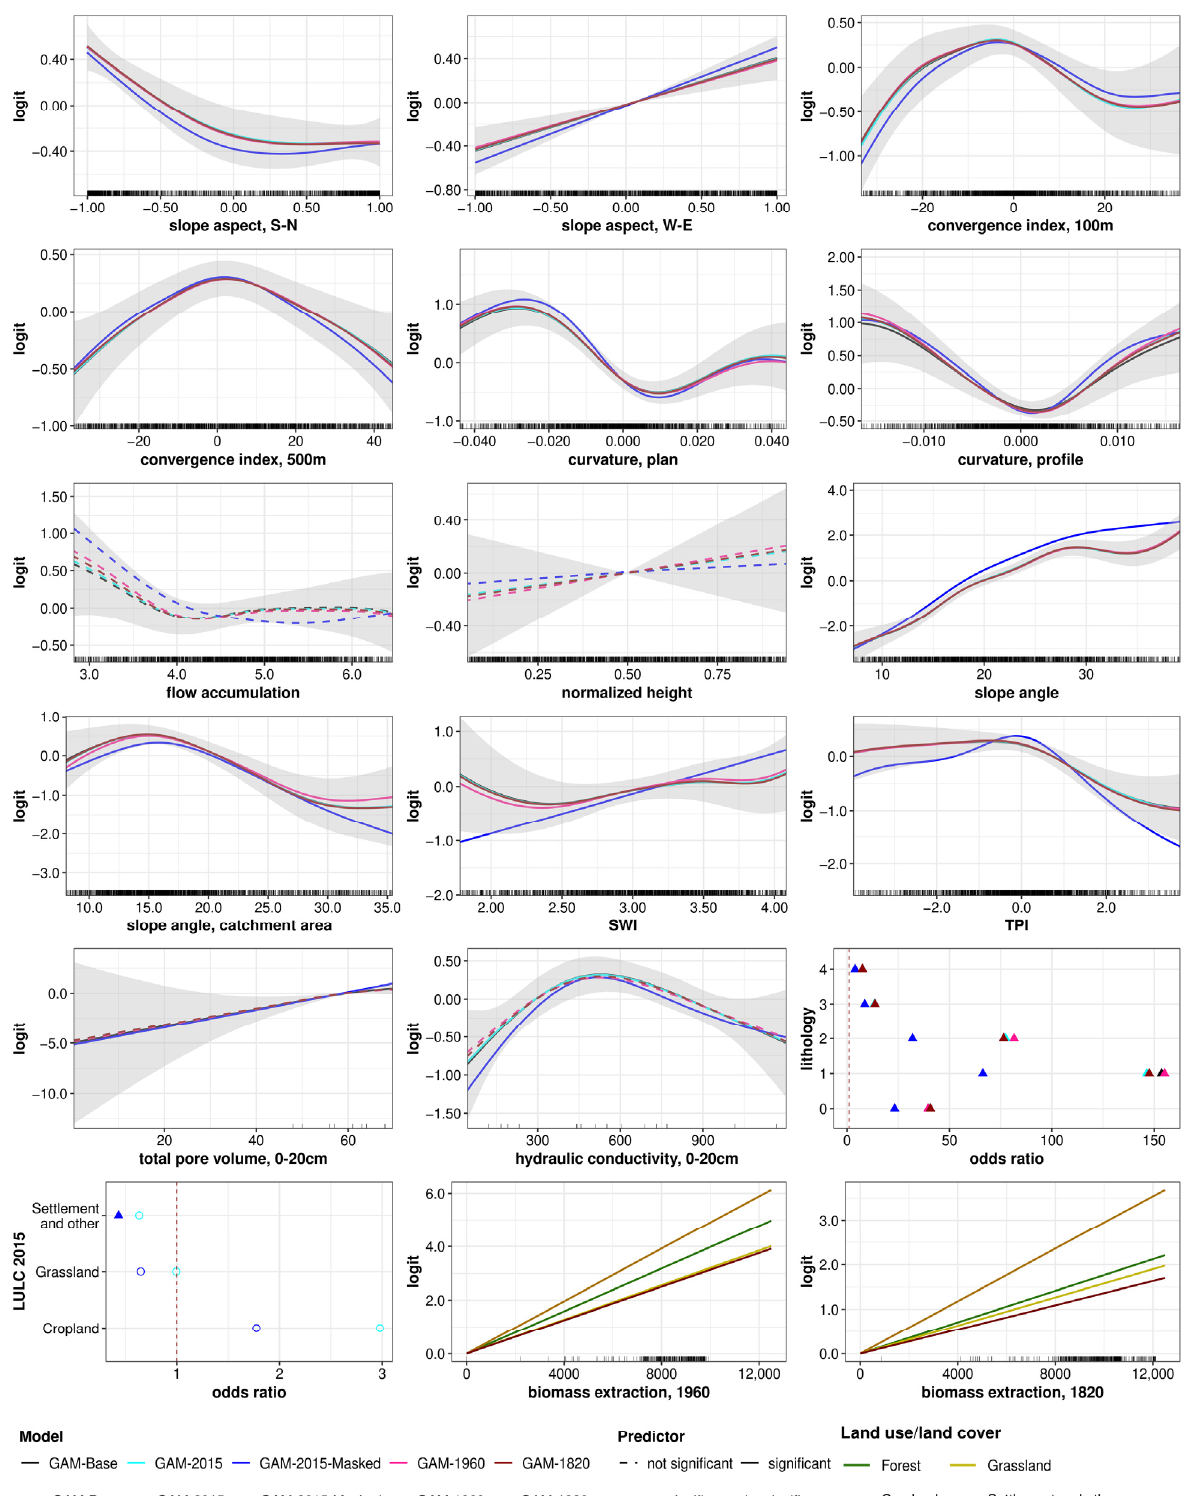
Figure A2. Predictor-response relationships of landslide models in Waidhofen. Grey: 95% Bayesian credible interval of GAM-Base. Reference level of LULC 2015: ‘Forest’; Lithological units: Reference: ‘Upper Austroalpine limestone’, 0: talus and glacial deposits, 1: Inneralpine Neogene, 2: Klippen zone, 3: flysch zone, 4: Upper Austroalpine marls. Note: the y axes are plot-dependent, and the x axes of non-parametric transformation functions are limited to the 5th to 95th percentile range.